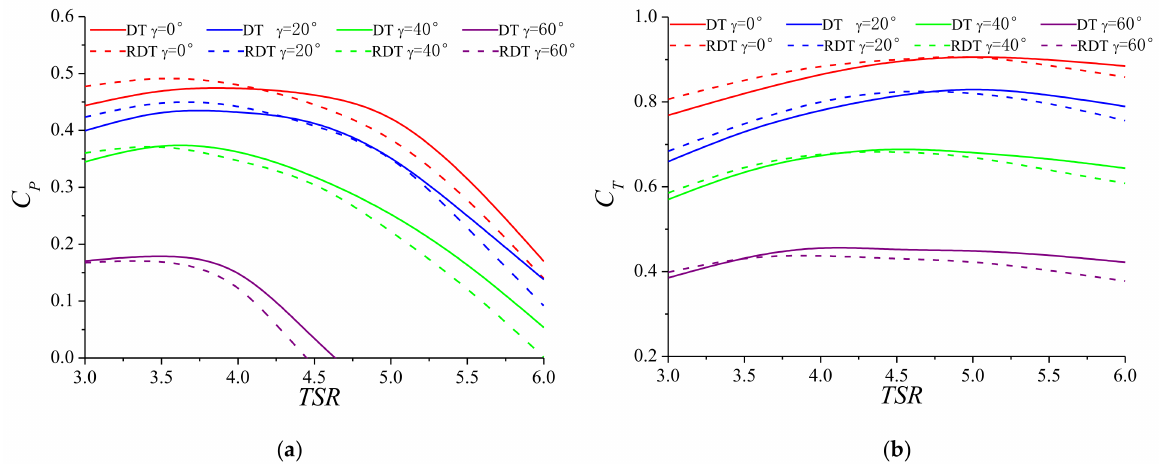
Figure 9. C P and C T versus TSR for the two configurations: ( a ) C P ; ( b ) C T .